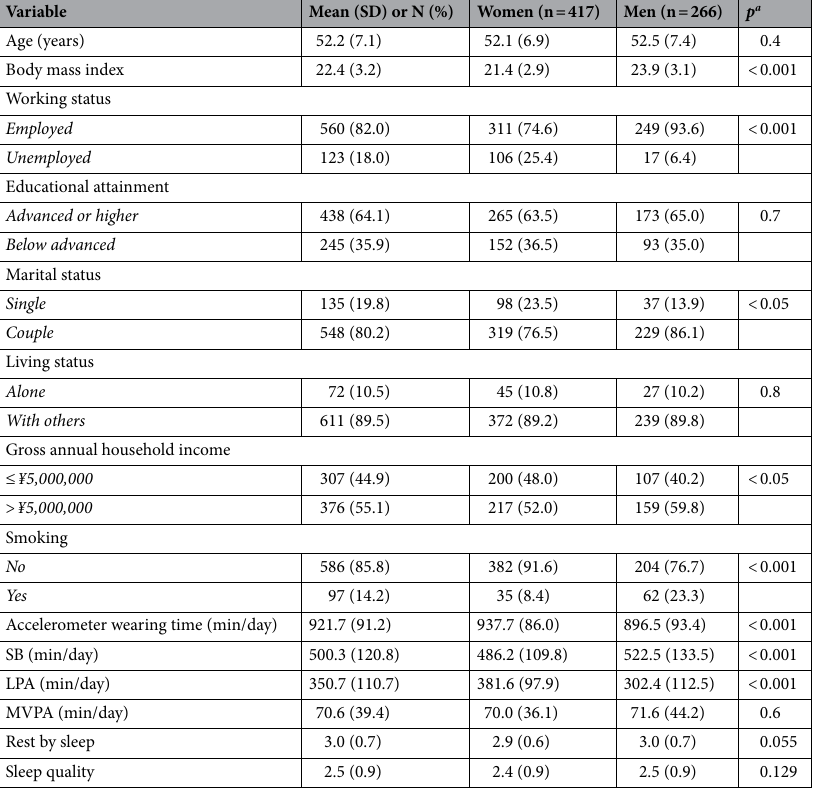
Table 1. Characteristics of study participants (N = 683). a Based on an independent t-test or Chi-squared test. SB sedentary behaviour, LPA light-intensity physical activity, MVPA moderate-to-vigorous physical